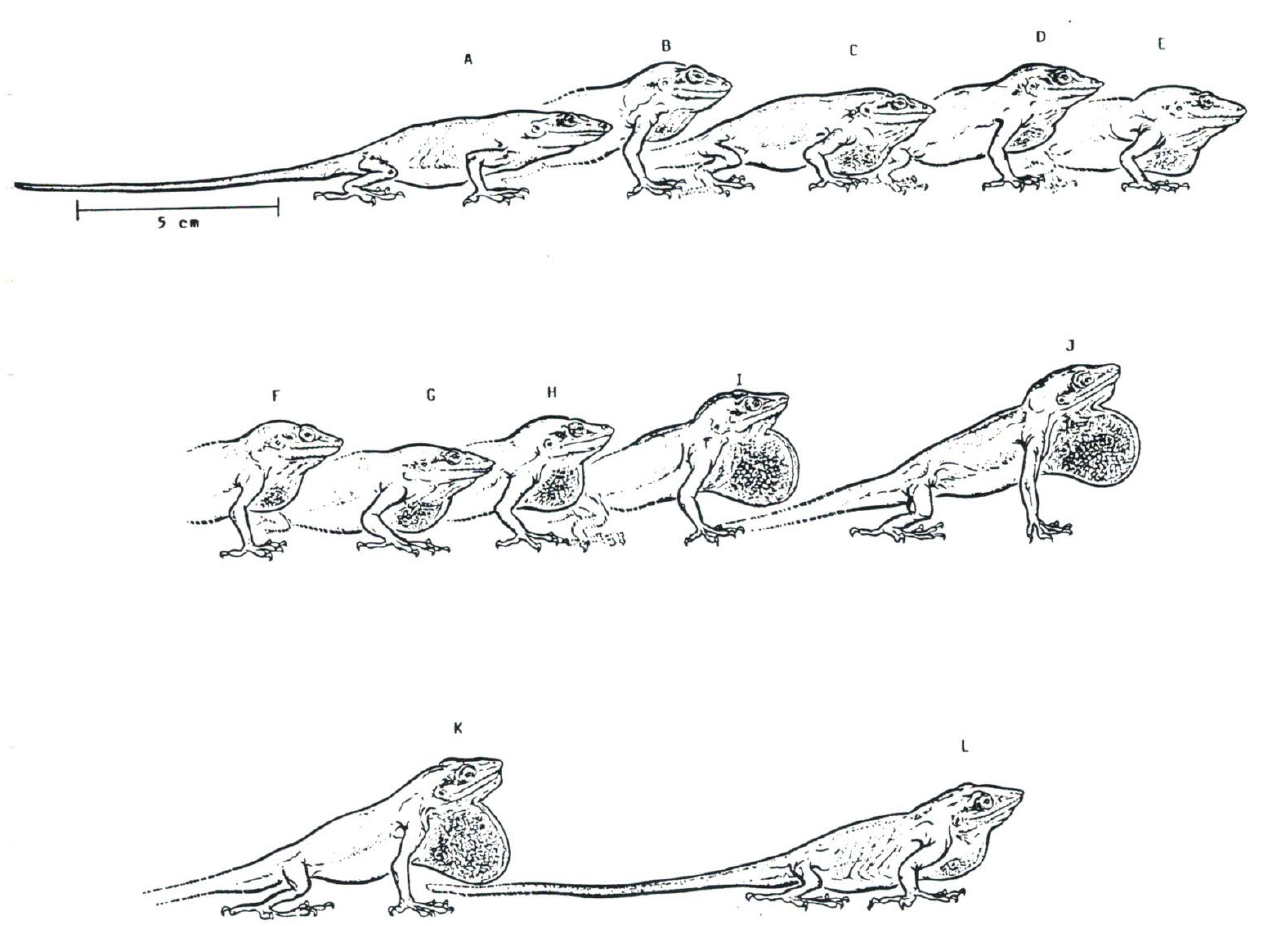
Figure 13. ( A – L ) Series of postures illustrating throat display movements (dewlap) in Anolis carlinensis . The time between each image is 0.01 s.